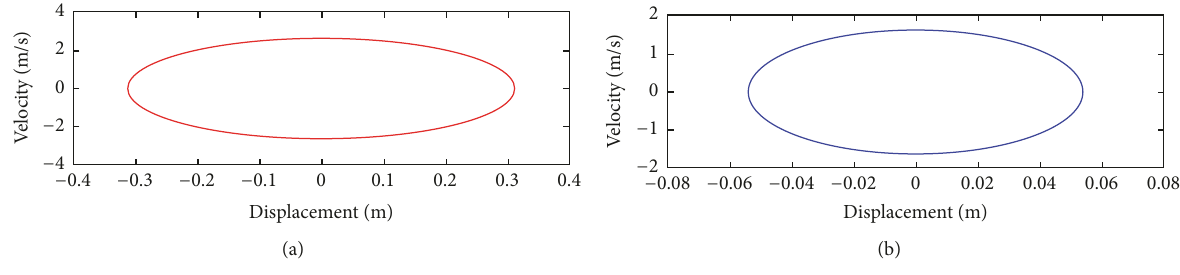
Figure 10: Phase portrait: (a) Ω = 8.2 rad/s, (b) Ω = 40